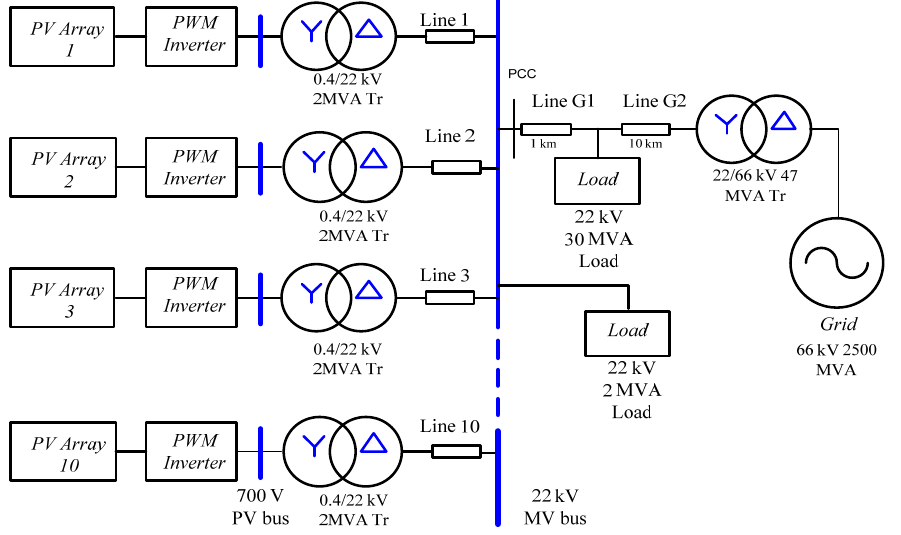
Figure 2. Block diagram of a 20 MW PV power plant.